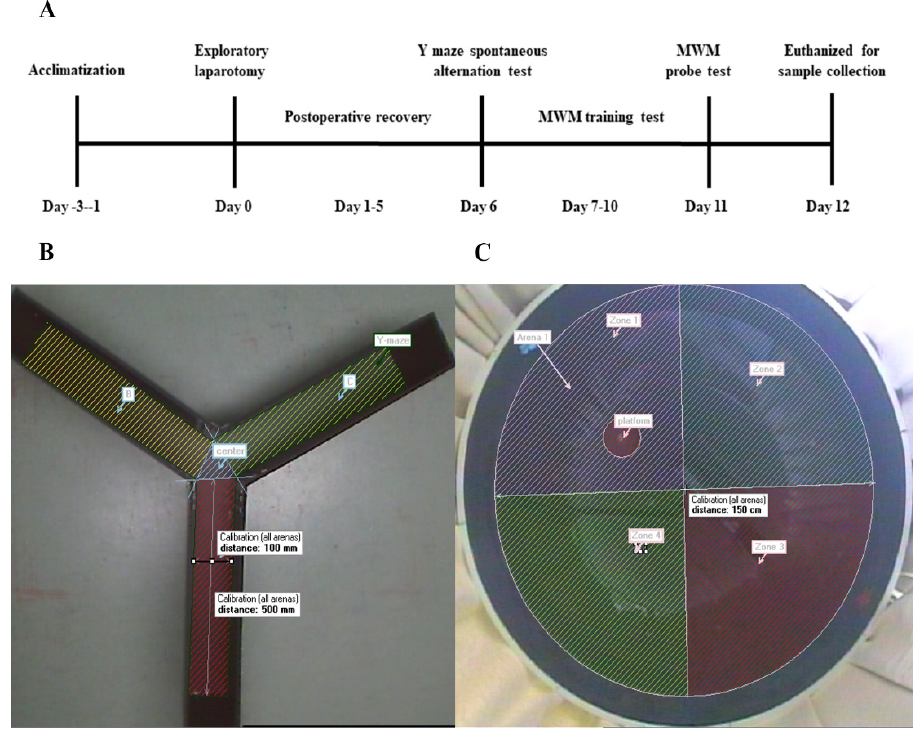
Figure 1. Study design to evaluate the effects of intraoperative hypothermia on postoperative cognitive function in rats. ( A ) Schematic timeline of the experimental procedure; ( B ) representative image of Y-maze apparatus; ( C ) representative graph of the MWM apparatus.